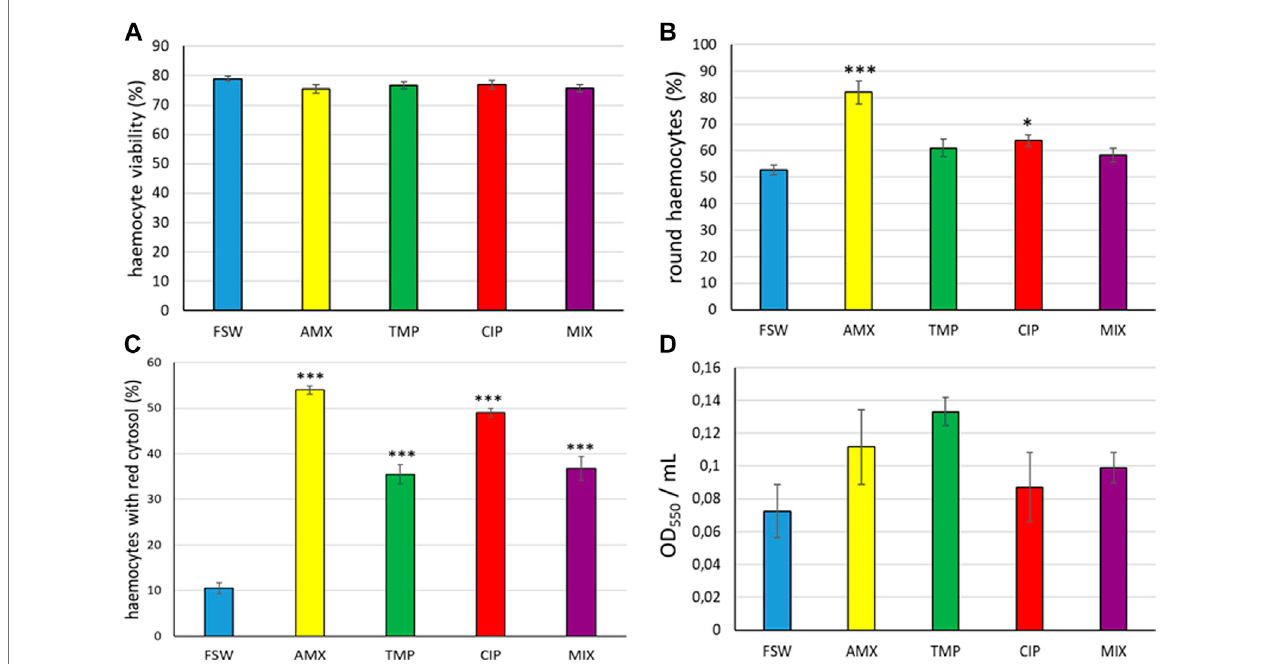
FIGURE 1 | Haemocytes of R. philippinarum exposed to AMX, TMP, CIP and MIX. (A) Percentage of viable haemocytes. (B) Percentage of round-shaped haemocytes stained with Giemsa. (C) Percentage of haemocytes showing Neutral Red loss into the cytoplasm. (D) Neutral Red uptake by haemocytes. Values are means +SD, n = 4. Asterisks denote signi fi cant differences with respect to controls (FSW): * p < 0.05, ** p < 0.01, *** p < 0.001.